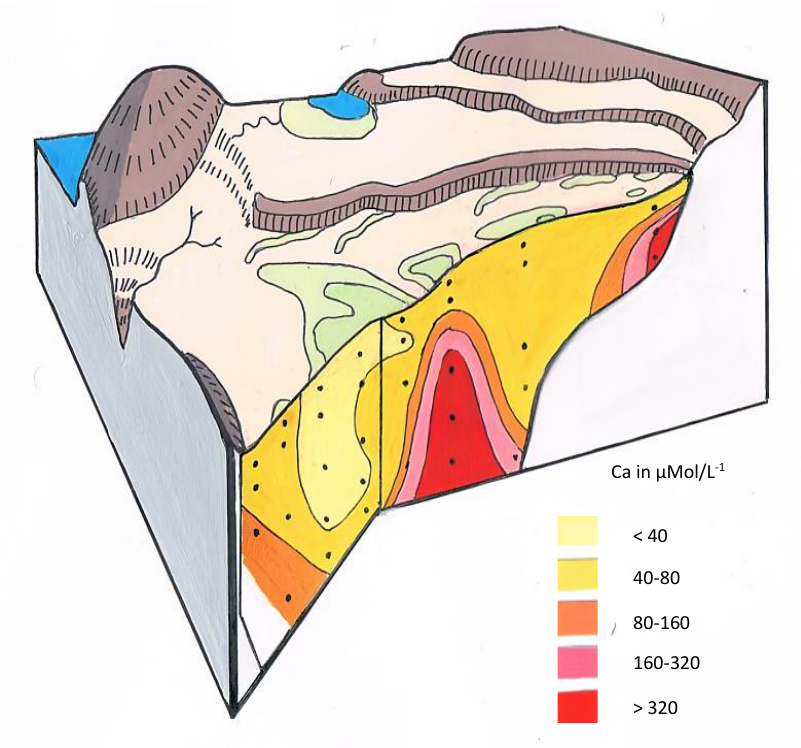
Figure 7. Calcium contents (µmol L -1 ) of pore water in peat profiles on Transects I and II. The vertical dots conform to sample locations.